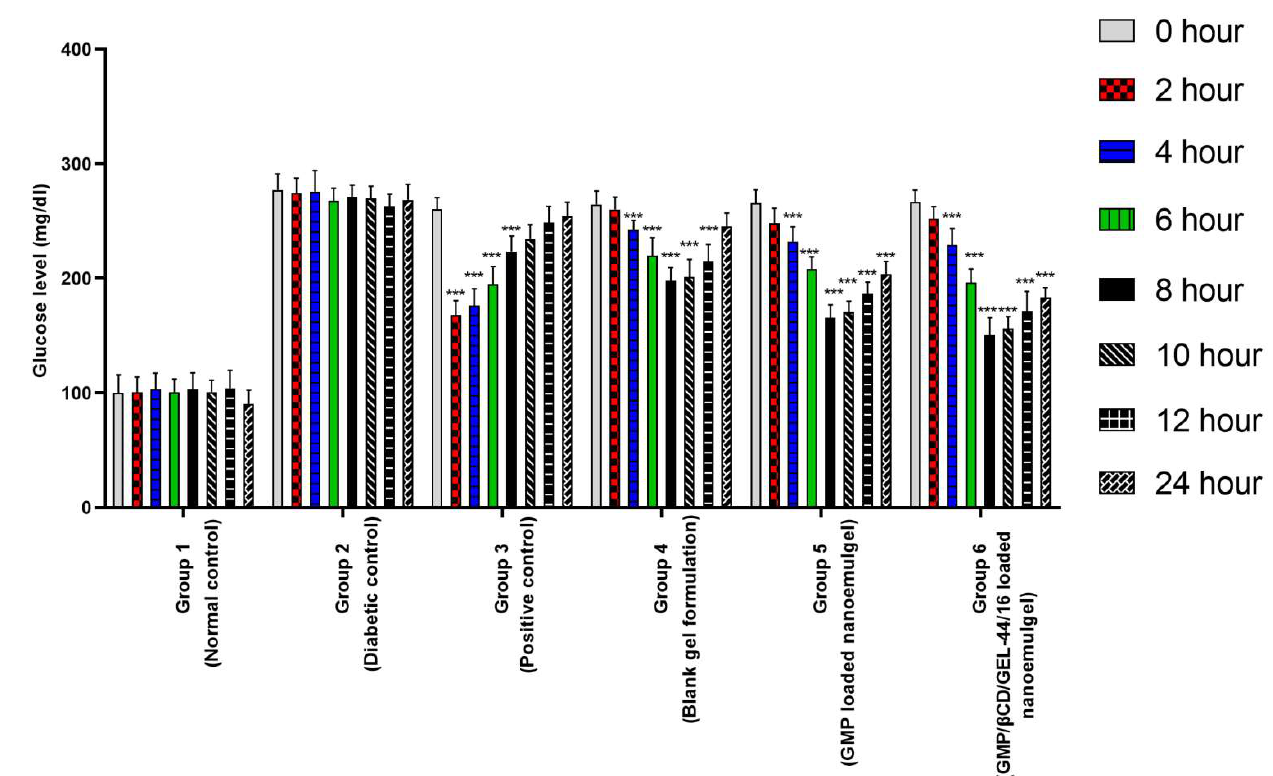
Figure 4. Hypoglycemic effect of GMP and GMP/ β CD/GEL-44/16-loaded nanoemulgels and marketed oral glimepiride in streptozocin-induced diabetes model. (*** indicates p < 0.001).